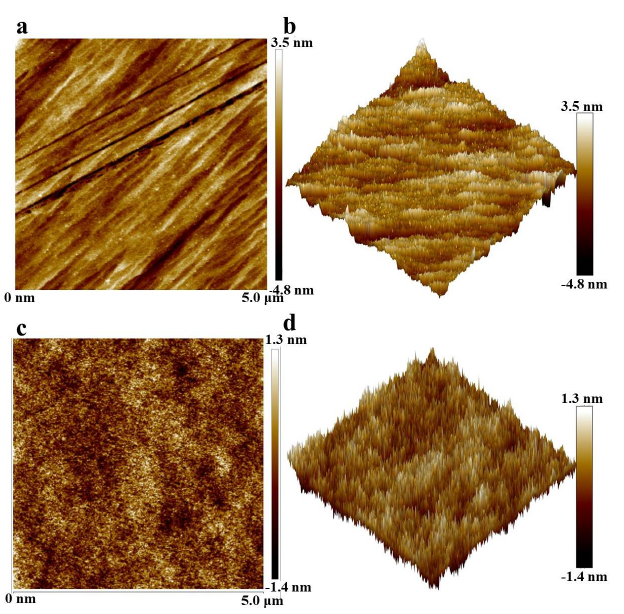
Figure 8. SEM images of ( a ) original water-wet calcite and ( b ) modified oil-wet calcite.